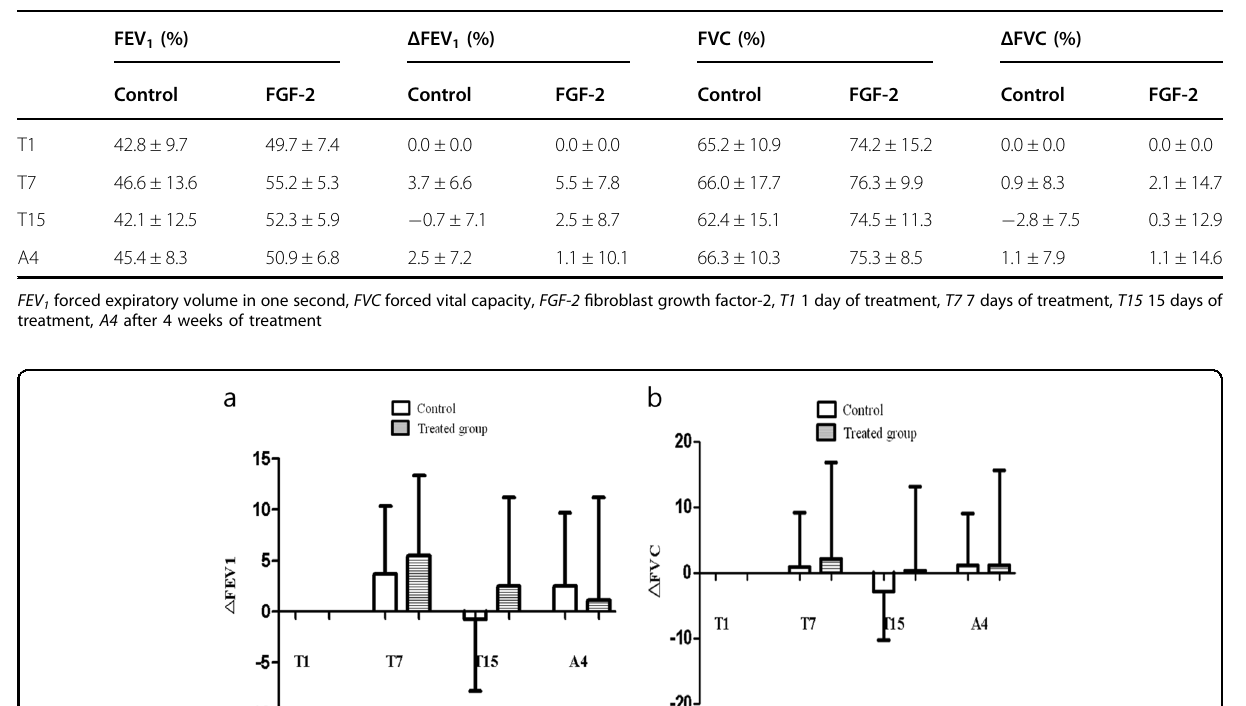
Table 2 Pulmonary function test (FEV 1 / Δ FEV 1 and FVC/ Δ FVC) of each group during and after FGF-2 treatment in the clinical trial